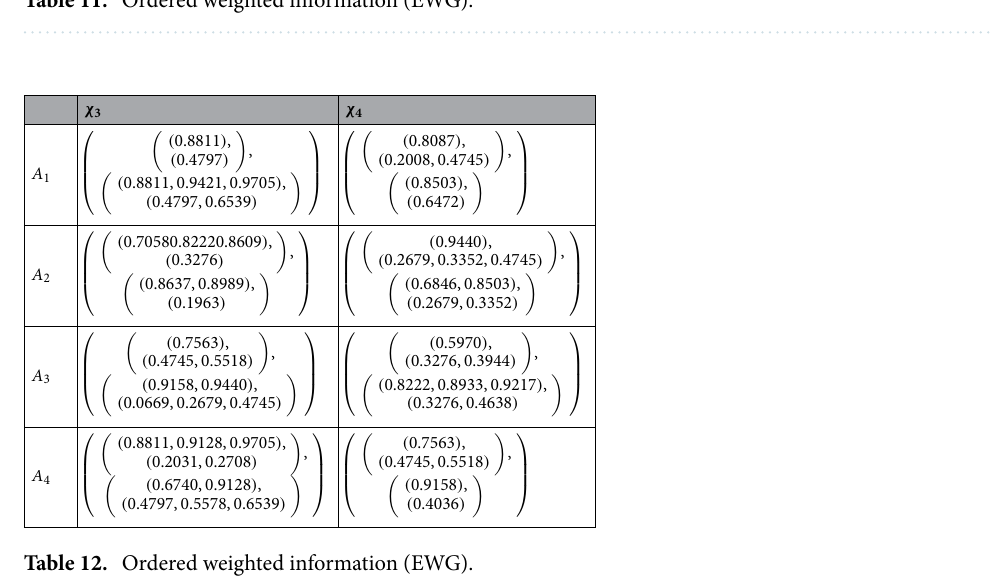
Table 11. Ordered weighted information (EWG).